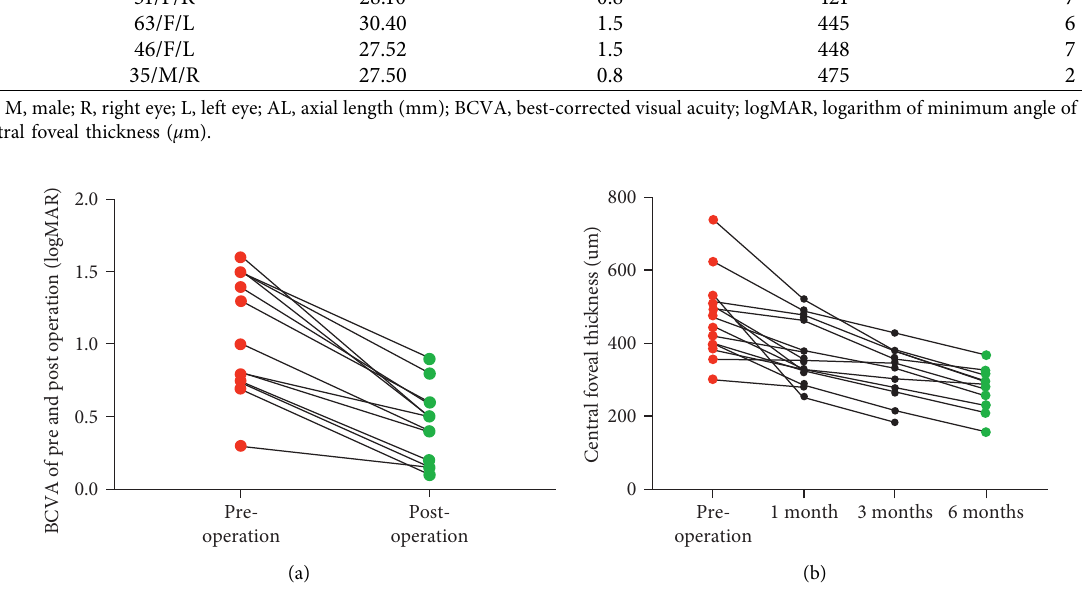
Figure 2: Pre and postoperative visual outcomes and central foveal thickness. The mean logMAR BCVA increased from 1.06 ± 0.42 to 0.45 ± 0.25 (a). The CFTdecreased from 479.62 ± 113.16 μ m to 372.38 ± 88.12 μ m, 316.18 ± 73.97 μ m, and 272.40 ± 61.32 μ m postoperatively at 1 month, 3 months, and 6 months, respectively